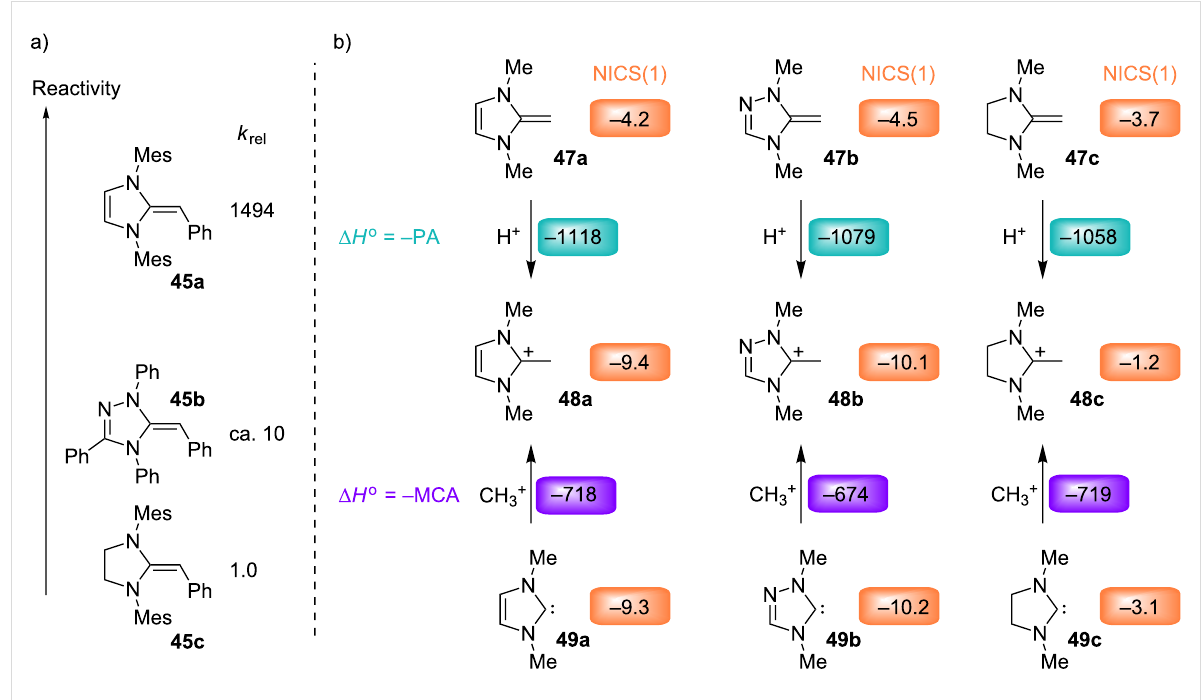
Figure 25: Comparison of the proton affinities (PA, from [107]) of the diaminoethylenes 47a–c with the methyl cation affinities (MCA, from [96]) of the corresponding carbenes 49a – c (in kJ mol –1 , MP2/6-31+G(2d,p)//B98/6-31G(d)), and the NICS(1) values of 47 – 49 (B3LYP/6-311+G(d)) (from [107]).